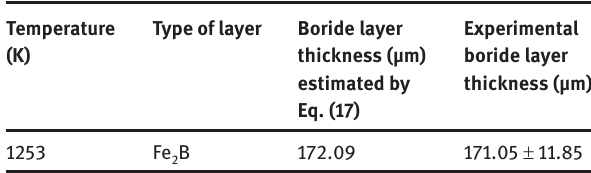
Table 3: Predicted and estimated value of the Fe 2 B layer thickness at 1253 K for 5 h of treatment.